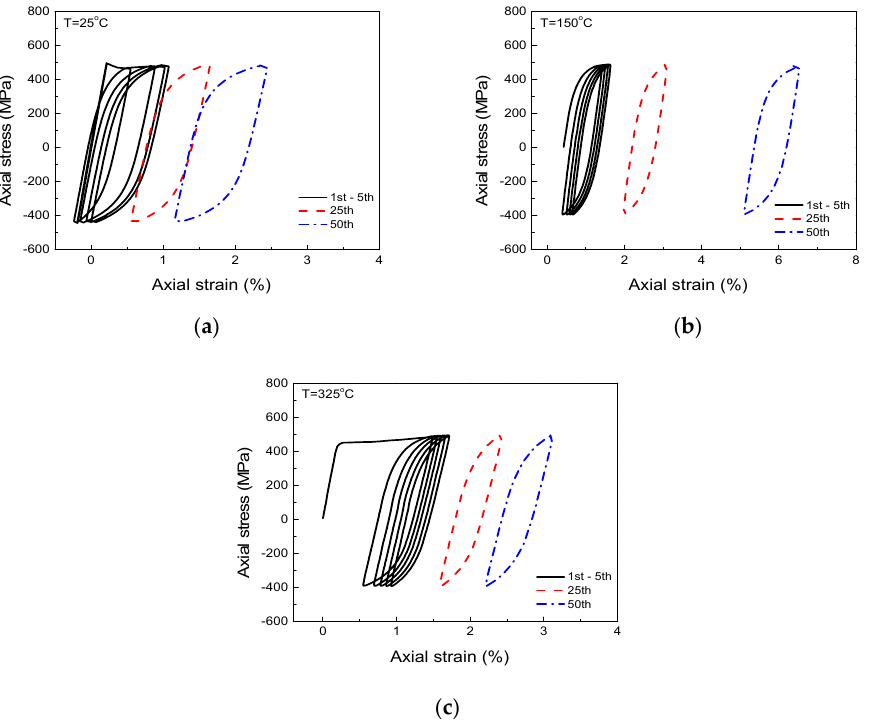
Figure 4. Experimental stress-strain curves under stress-controlled cycling at ( a ) 25 °C, ( b ) 150 °C and ( c ) 325 °C.